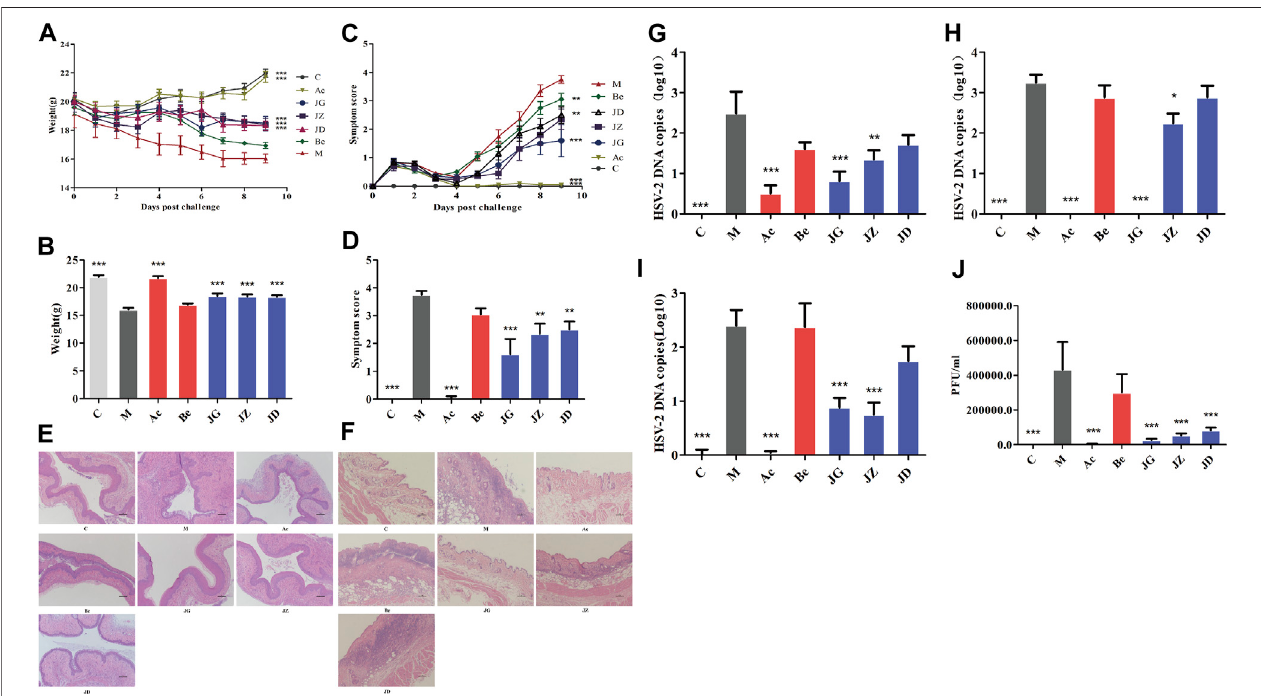
FIGURE 6 | Effect of JZ-1 on GH mice. Effect of JZ-1 on body weight (A, B) , symptoms score (C, D) , vagina (E) and vulva (F) histomorphology ( × 100), vagina (G) , vulva (H) , and spinal cord (I) viral load, virus titer of vaginal washings (J) of GH mice was evaluated. The data of (B, D) showed the statistical analysis results of body weight and symptoms score on day 9. The data of (E-I) was also from day 9, and (J) was from day 3. C, control group; M, model group; Ac, acyclovir group; Be, berberine group; JG, JZ, JD: 2.5, 1.5, and 0.5 g/ml JZ-1 group. *p ＜ 0.05, **p ＜ 0.01, ***p ＜ 0.001 vs. M group.